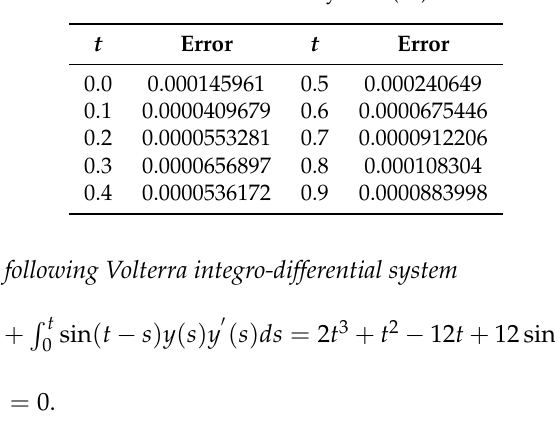
Figure 2. Comparison of approximate and exact solutions of System (12) for the case r = 3 and q = 4. Table 2. Absolute errors in solution of System (12) with r = 3 and q =